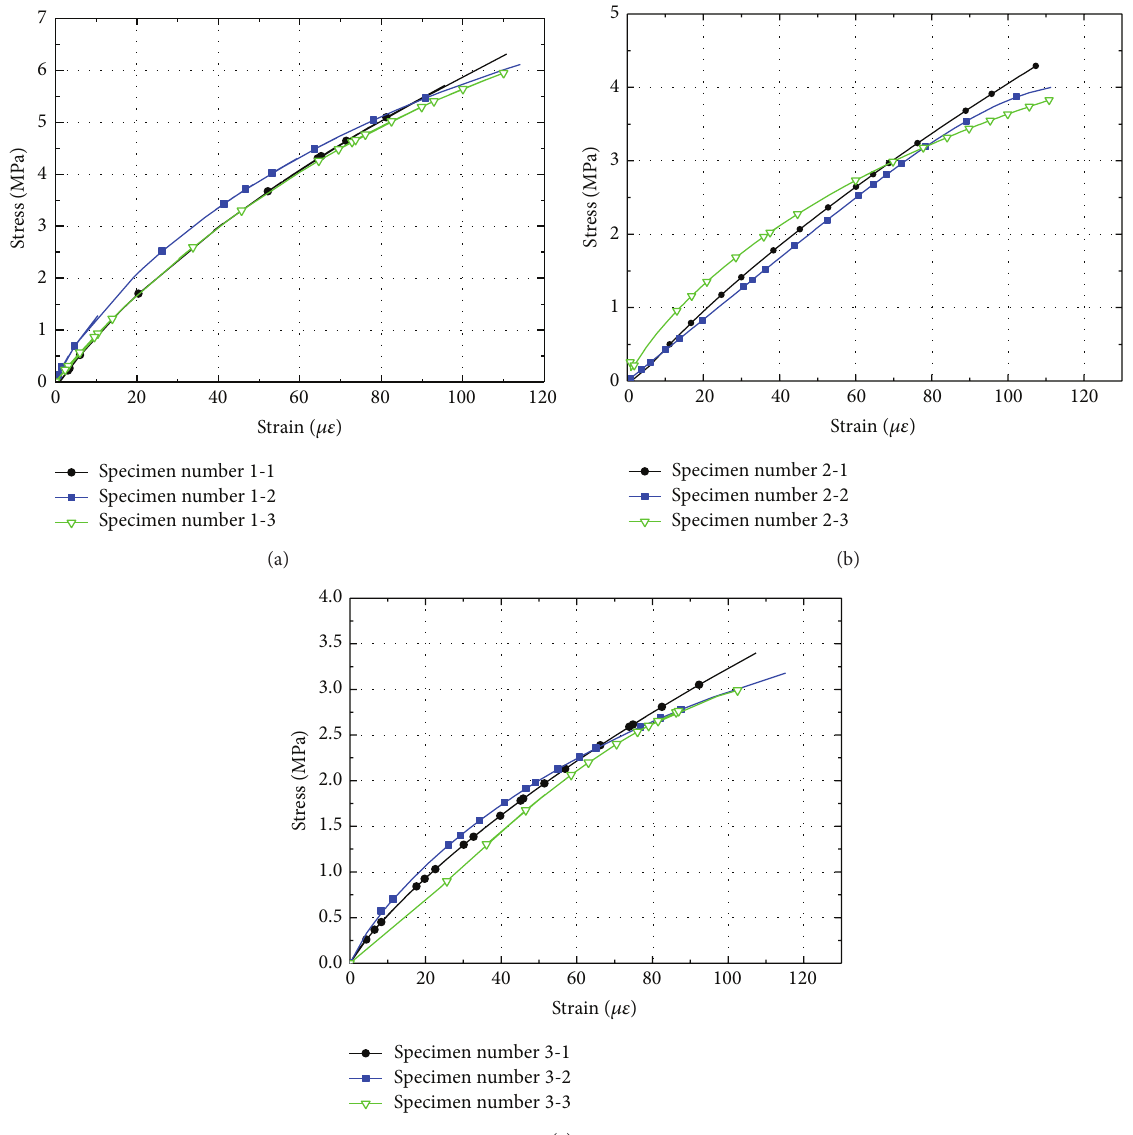
Figure 9: Influence of beam size on stress-strain curves of cement mortar: (a) beam depth 40mm; (b) beam depth 100 mm; (c) beam depth 150